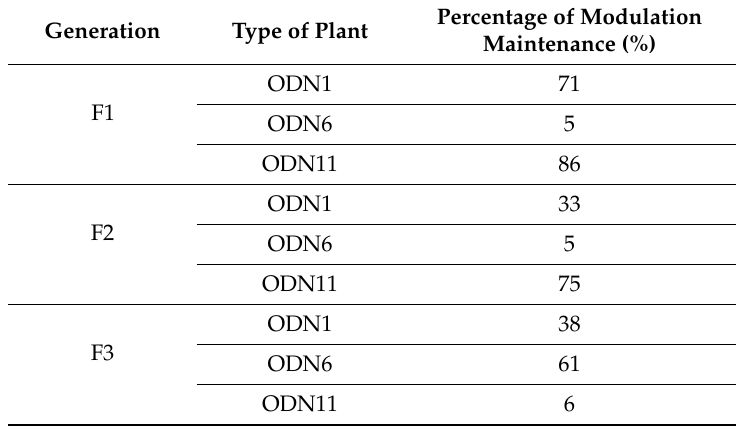
Table 2. Maintenance of gene expression modulation of CHS gene in F1, F2 and F3 generations of plants treated with short oligodeoxynucleotides